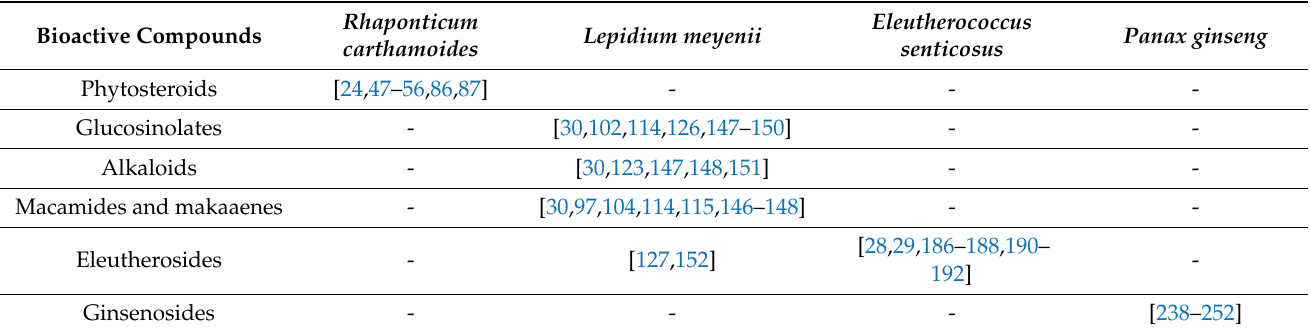
Table 6. Comparison between the main bioactive compounds in Rhaponticum carthamoides , Lepidium meyenii , Eleutherococcus senticosus , and Panax ginseng